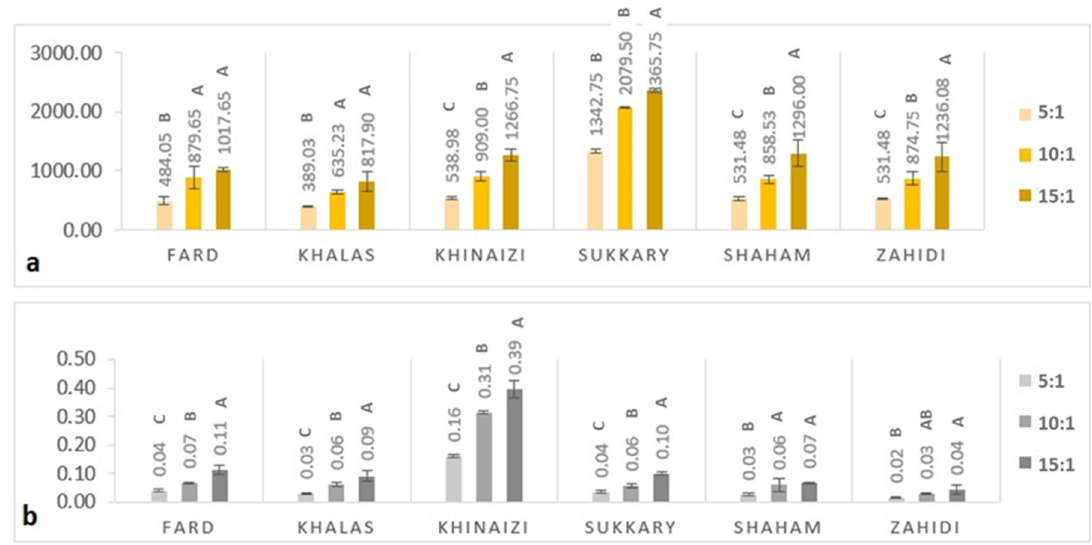
Figure 1. ( a ) TPC (Gallic acid equivalent per gram ( µ g/g) of the sample); ( b ) Flavonoid content ( w/w ) % of six varieties of date seed powder extracted at three sample to solvent ratios (5:1, 10:1, and 15:1). Different uppercase superscript letters in a variety denote significant differences, p < 0.05.